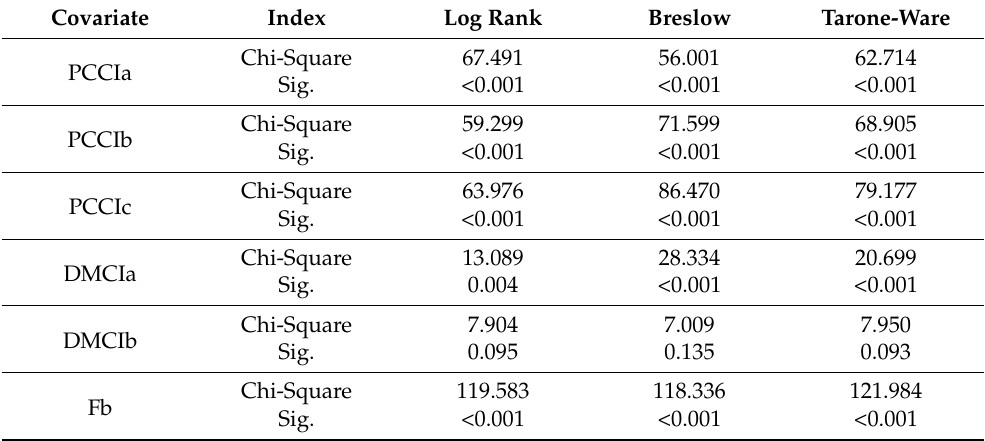
Table 5. Chi-Square and Significance